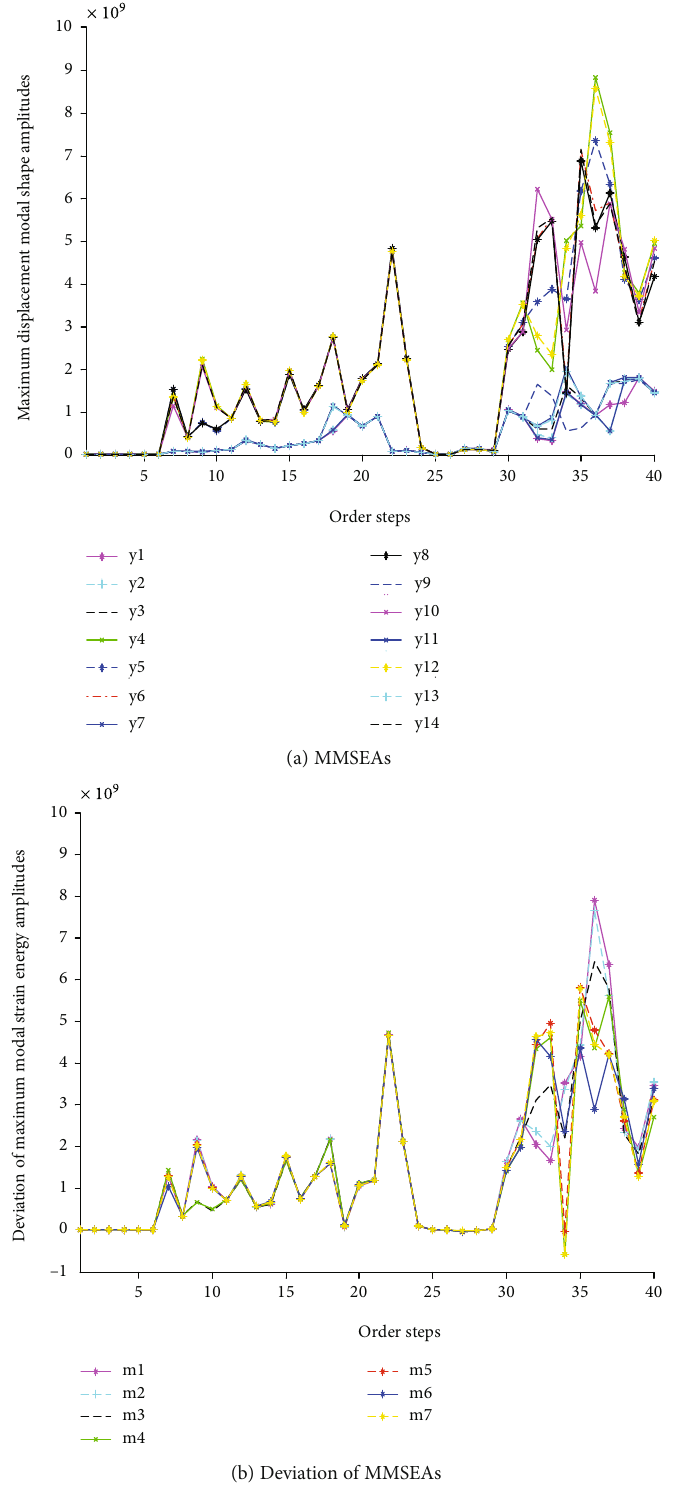
Figure 10: Maximum modal strain energy amplitudes analysis in di ff erent rotational speeds and temperatures. (a) MMSEAs: tuned blisk: y1: